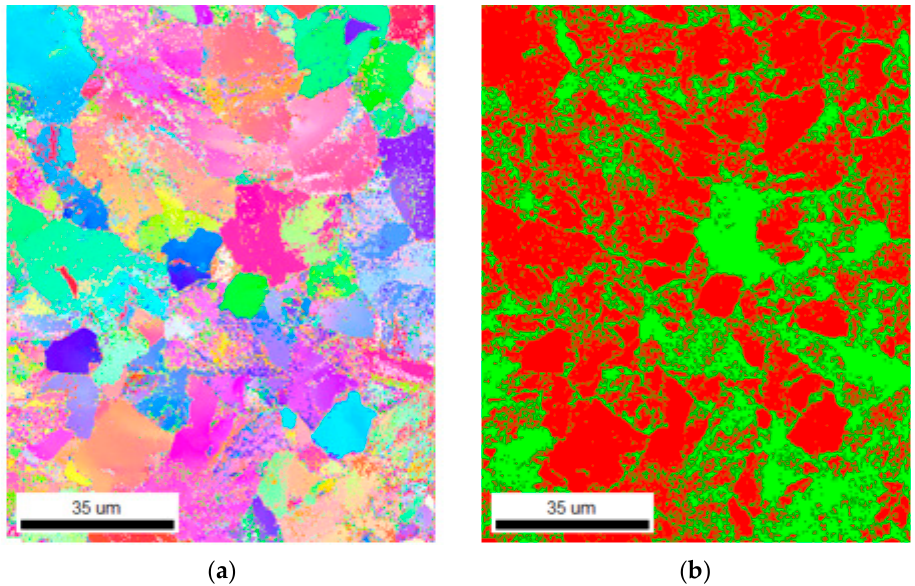
Figure 4. Cross-sectional electron backscatter diffraction (EBSD) analysis of the AR specimen. ( a ) inverse pole figure (IPF) map and ( b ) phase map.